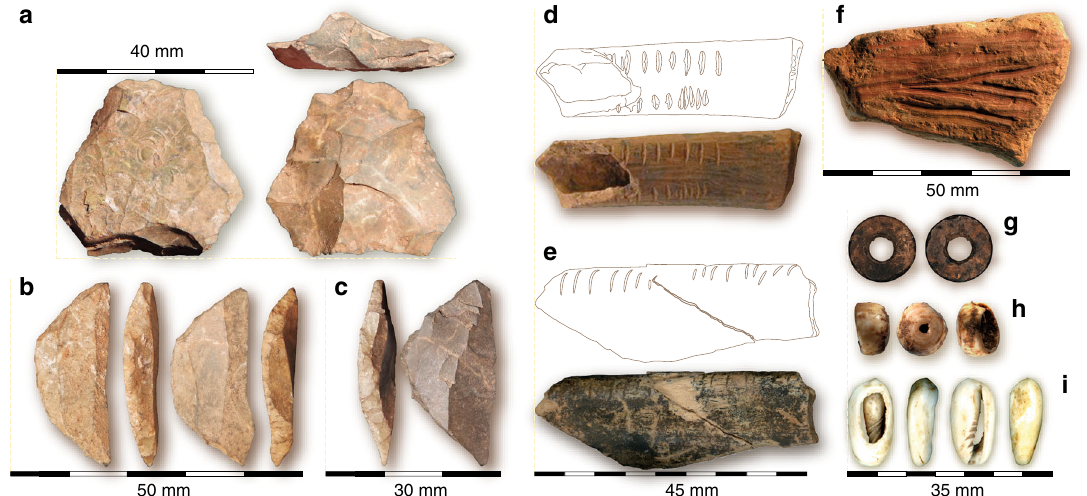
Fig. 2 Selected artifacts from PYS. a Levallois core from Layer 11. b Two backed lithic artifacts from Layer 11. c Backed lithic artifact from Layer 3. d Notched bone from Layer 8. e Notched bone from Layer 9. f Ocher crayon from Layer 10. g Ostrich eggshell bead from Layer 8. h Conus shell bead from Layer 16. i Gastropod shell bead from Layer 4